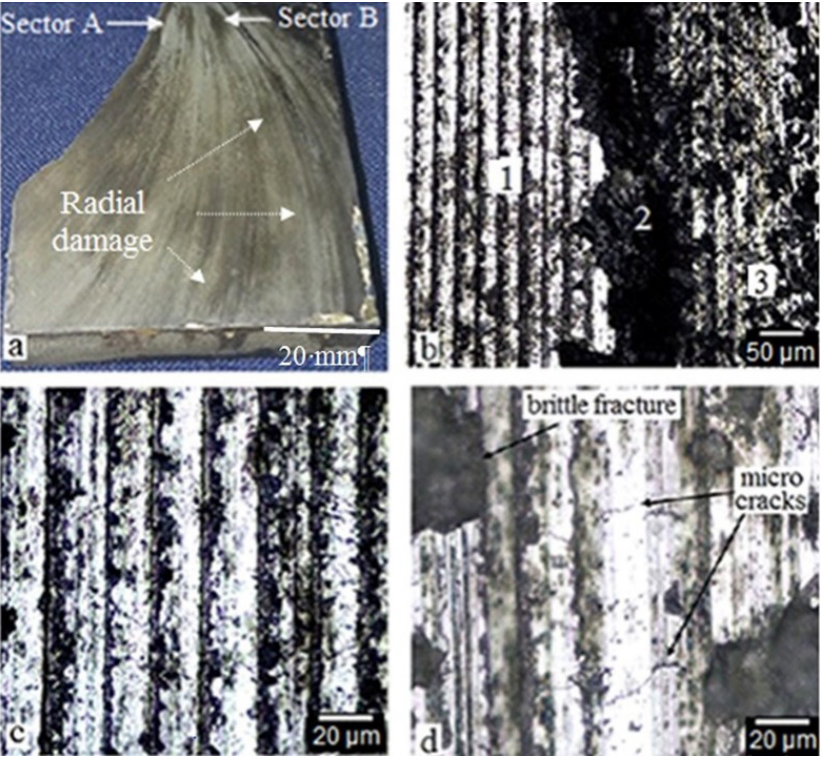
Figure 4. a) Photo of the β-SiC armor plate machined showing the sectors named A and B; (b) light micrographs of sector A; (c) region 1 of sector A, and (d) sector